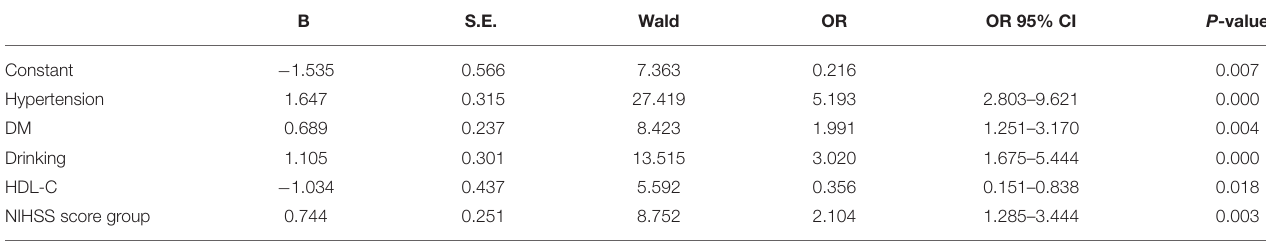
TABLE 5 | Multivariate logistic regression analyses of the risk factors associated with post-stroke anxiety (PSA) evaluated by Hamilton Anxiety Scale (HAMA) scale. B